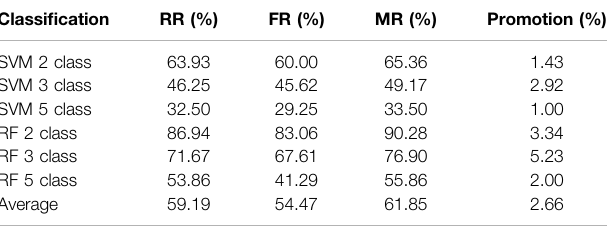
TABLE 1 | The classi fi cation accuracy is obtained by SVM and RF classi fi ers, where 2-, 3, and 5-class gesture classi fi cation problems are considered. For all the tests, 20 realsamples in each gesture are used to test the classi fi ers trained by real data (RR), synthetic data (FR), and both real data and synthetic data (MR).